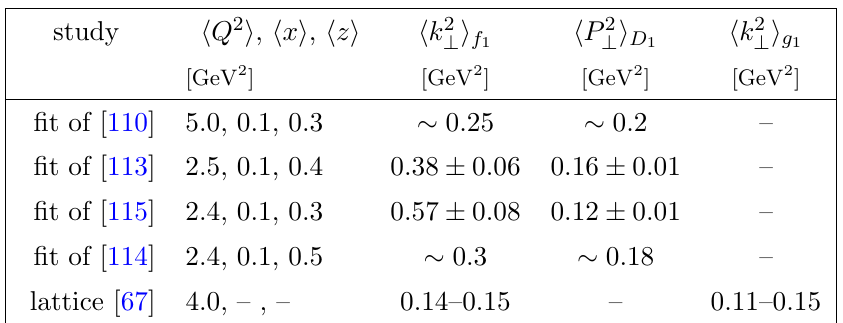
Table 1. Gaussian model parameters for f a and lattice QCD studies. The kinematics to which the phenomenological results and the renor- malization scale of the lattice results are indicated. The range of lattice values indicates (cid:13)avor dependence ((cid:12)rst number refers to u -(cid:13)avor, second number to d